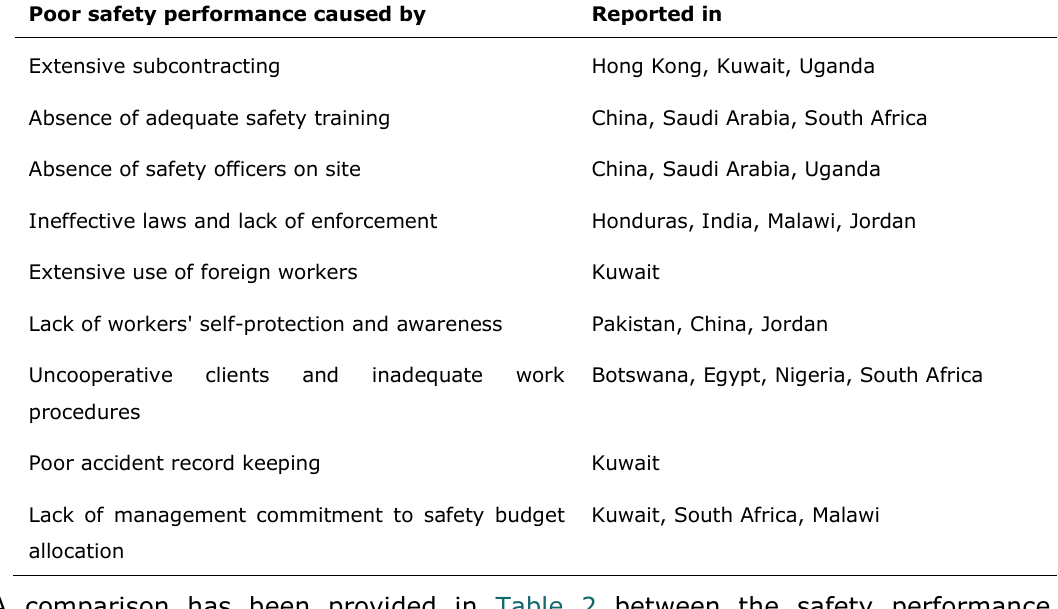
Table 1. Sources of poor performance of construction safety in developing countries (Awwad et al., 2014) Poor safety performance caused by